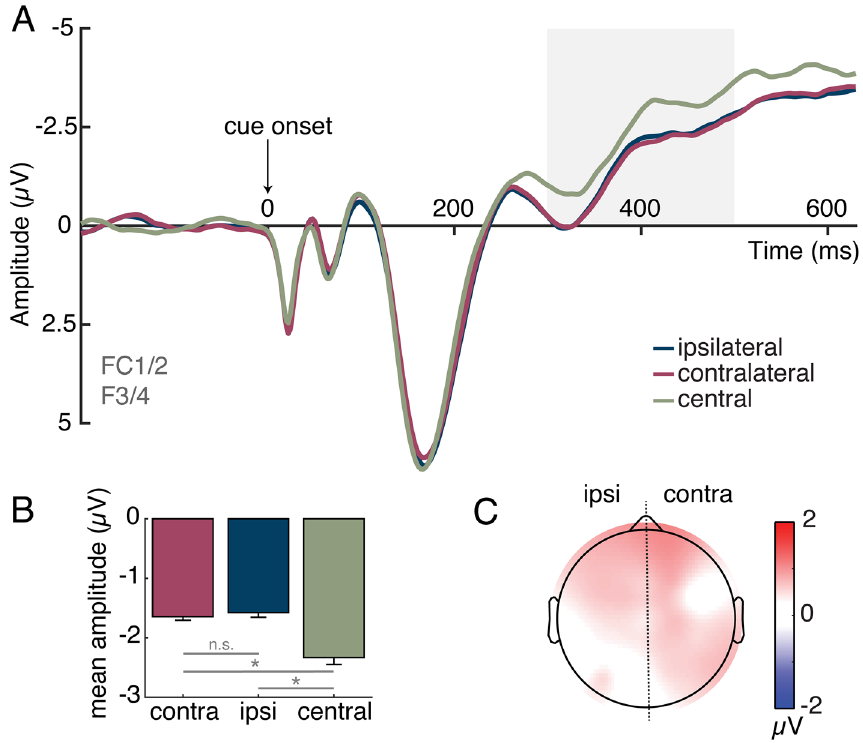
Figure 2. Grand-average ERP waveforms, mean amplitudes, and ERP topography during the shift-related potential (SRP) time window (300–500 ms). ERPs at frontal scalp sites (F3/F4/FC1/FC2) were collapsed over left- and right-cue conditions and left and right hemispheres to obtain waveforms recorded ipsilaterally and contralaterally to the cued location. For the central-cue condition, ERPs were computed by averaging bilaterally across the same set of electrodes. ( A ) Plot of cue-elicited ERP. There was a significant positivity in ipsilateral and contralateral hemispheres in comparison to the no-shift cue (central) during the a priori defined SRP time window (highlighted in gray). ( B ) Plot of average ERP magnitude during the a priori SRP time window (300– 500 ms). There was a positivity in ipsilateral (ipsi) and contralateral (contra) cortex relative to the central cue. Error bars represent ± 1 standard error of the mean. Asterisks indicate a significant (p < .05) difference between conditions. ( C ) Topographical voltage map of the contralateral-central and ipsilateral-central ERP difference amplitudes during the SRP time window, with contralateral and ipsilateral differences projected to the right and left sides, respectively. The map demonstrates that the SRP was broadly distributed over bilateral frontal areas, concurrent with the posterior lateralized